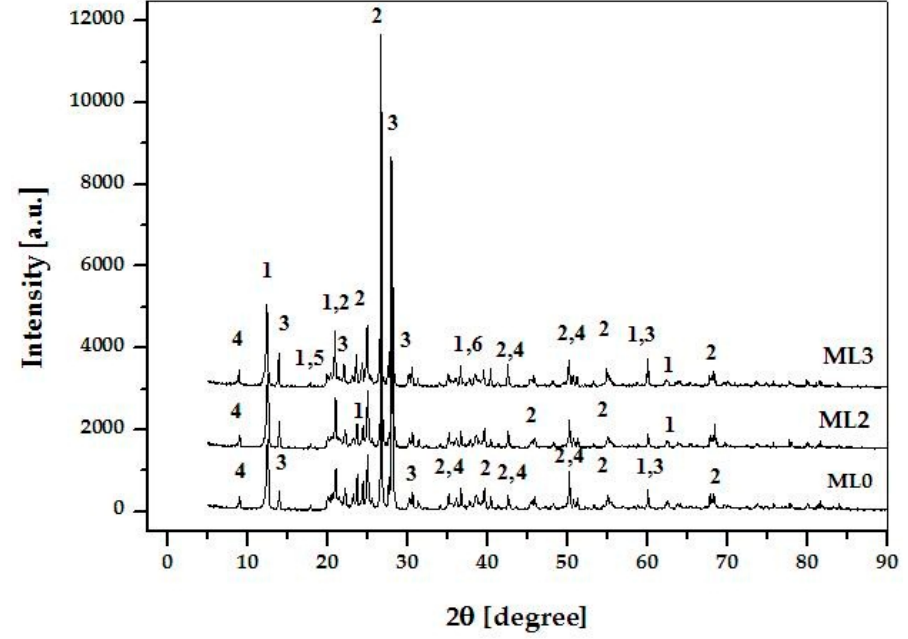
Figure 1. X-ray diffraction patterns of the floor tile formulations (1—kaolinite; 2—quartz; 3—albite; 4—mica; 5—gibbsite; 6—goethite).